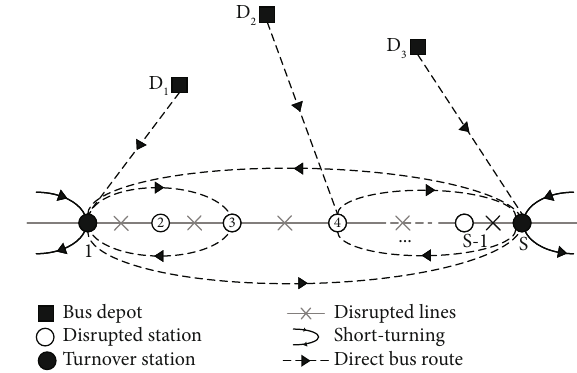
Figure 4: The local bus routes (LBR).